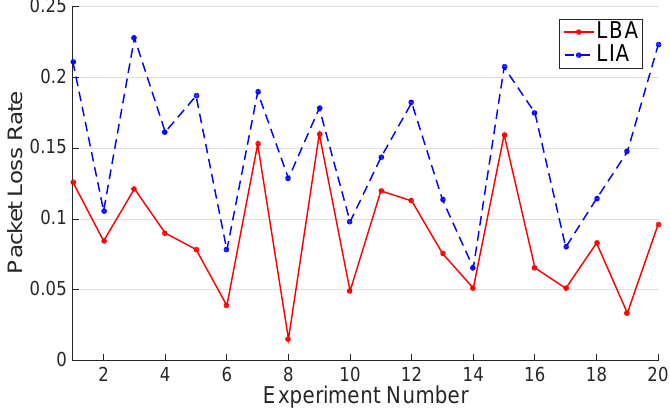
Figure 5. Loss rate with different